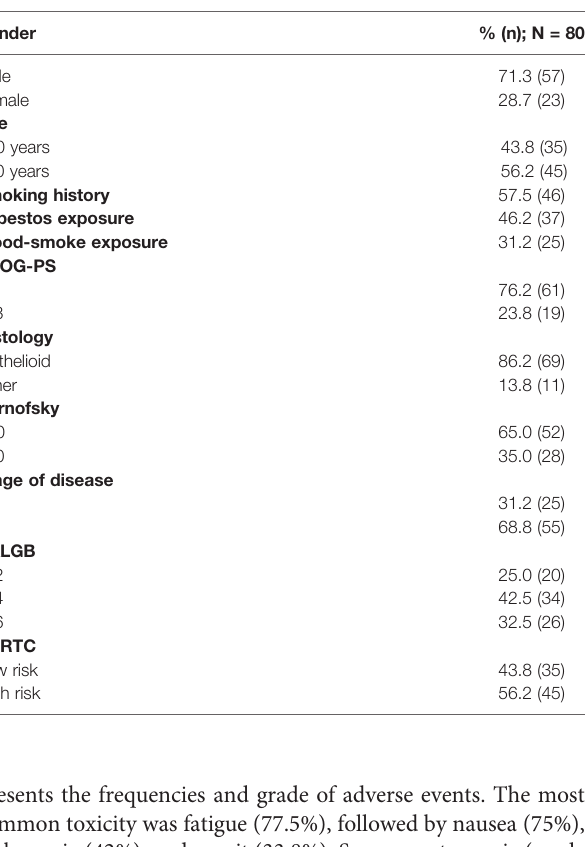
TABLE 1 | Baseline characteristics of